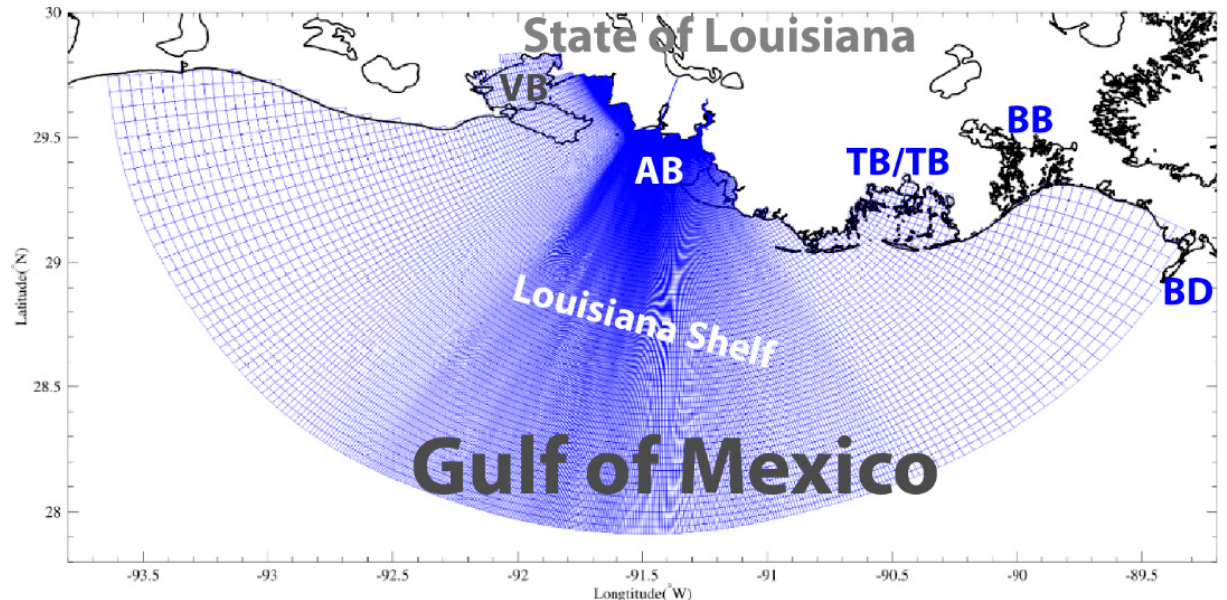
Figure 3. The 380 × 250 curvilinear model grid of the Atchafalaya-WLD system. VB: Vermilion Bay; AB: Atchafalaya Bay; TB/TB: Timbalier Bay/Terrebonne Bay; BB: Barataria Bay; BD: Birdfoot Delta.